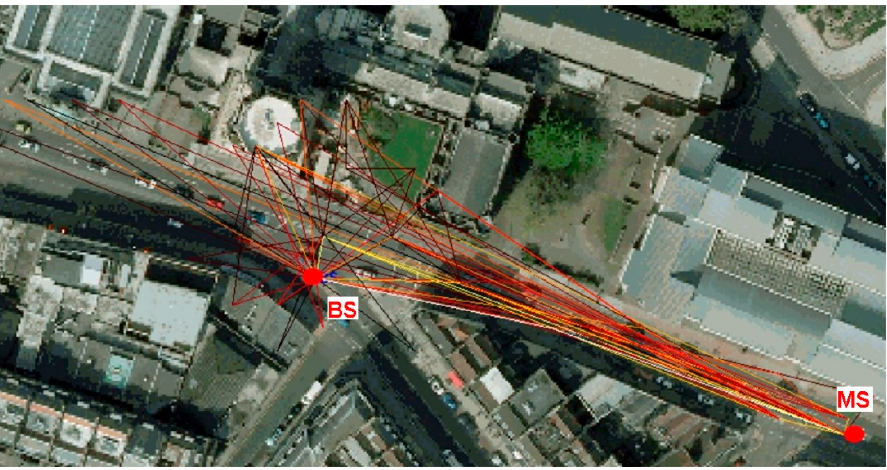
Figure 1. Multipath rays for a BS-MS point-to-point link.